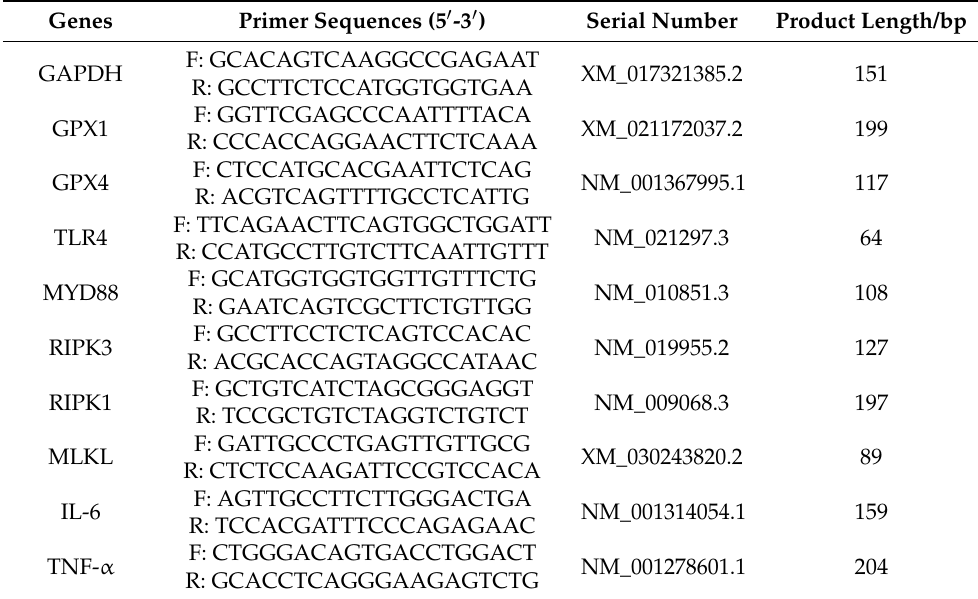
Table 3. The primers used for quantitative real-time